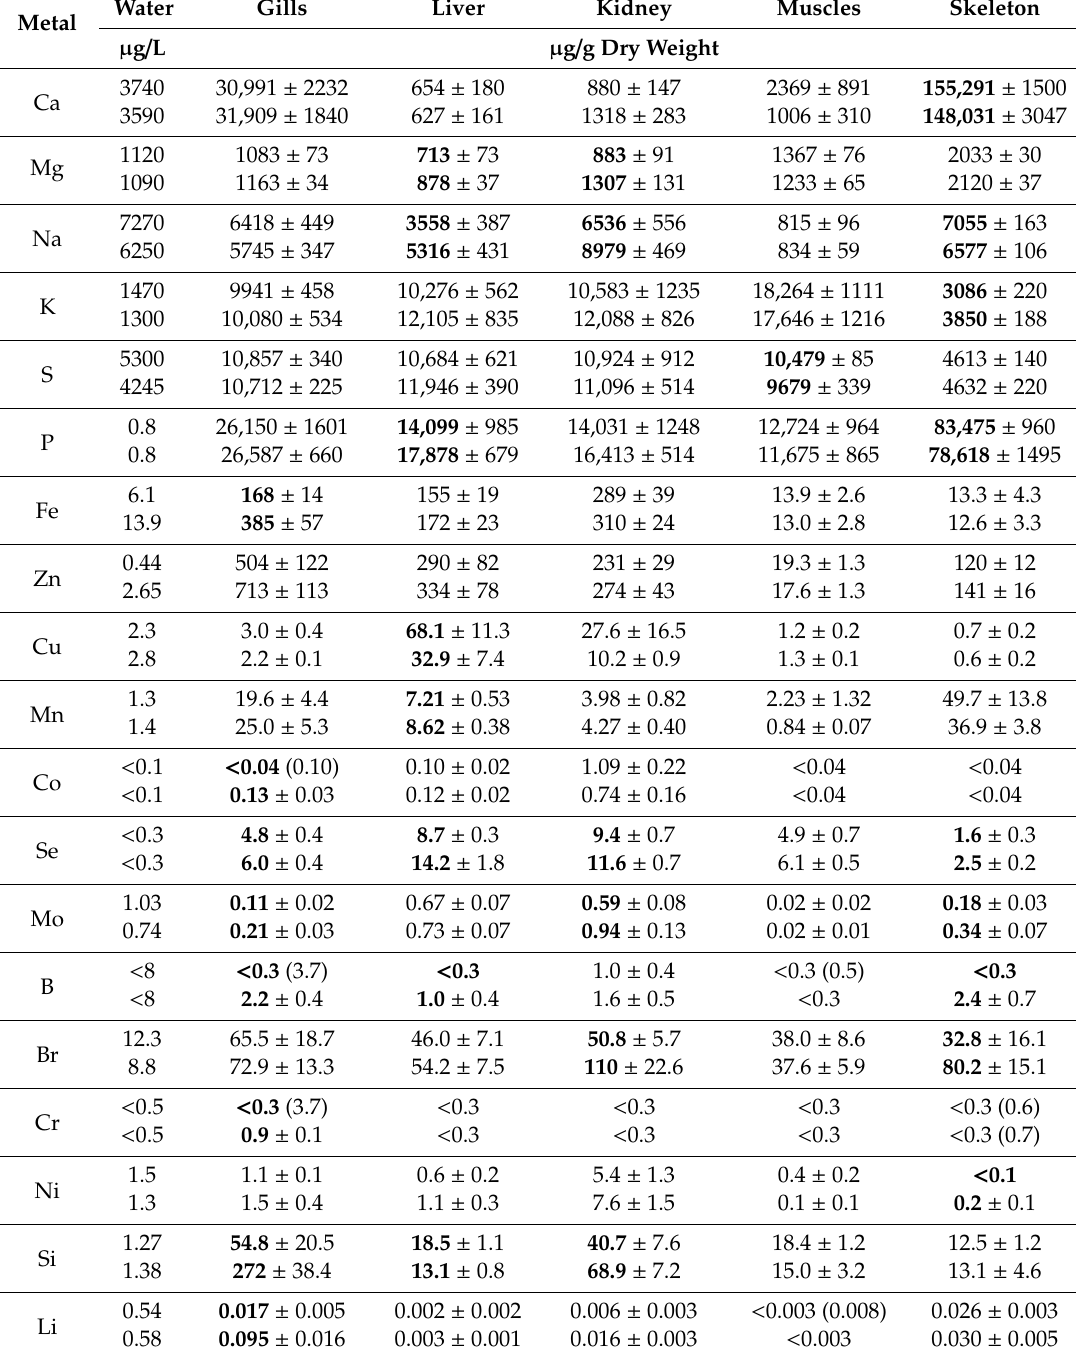
Table 1. Average values and standard errors of the essential and conditionally essential metal concentrations in the water, organs and tissues of the whitefish caught from area I-7 (top line) and area I-8 (bottom line). The maximum values are shown in brackets. The bold type shows a reliable di ff erence (with a significance level p < 0.05) in the average values of the metal